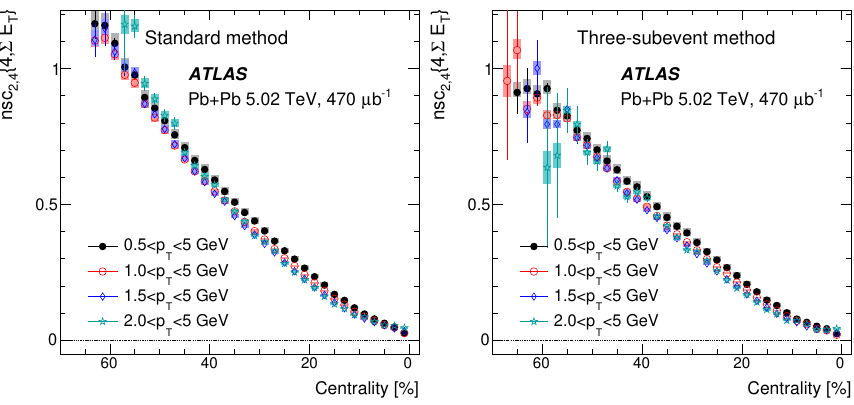
Figure 11 . The centrality dependence of nsc 2 ; 4 f 4 g calculated for charged particles in four p T ranges with the standard method (left panel) and three-subevent method (right panel). The error bars and shaded boxes represent the statistical and systematic uncertainties, respectively. Zero is indicated by a dotted